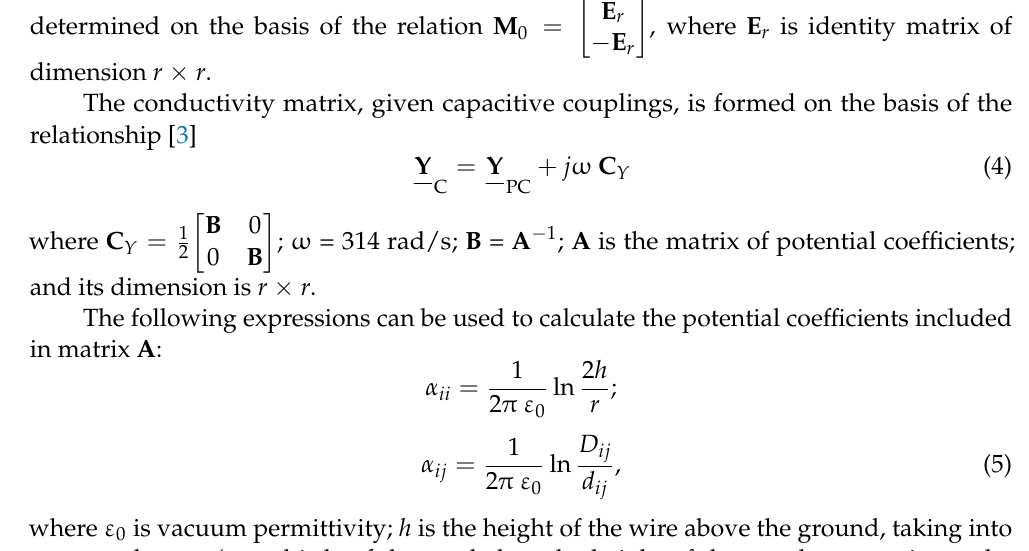
Figure 5. Original circuit of the power transmission line. Phase coordinates are the most natural description of three-phase power systems.